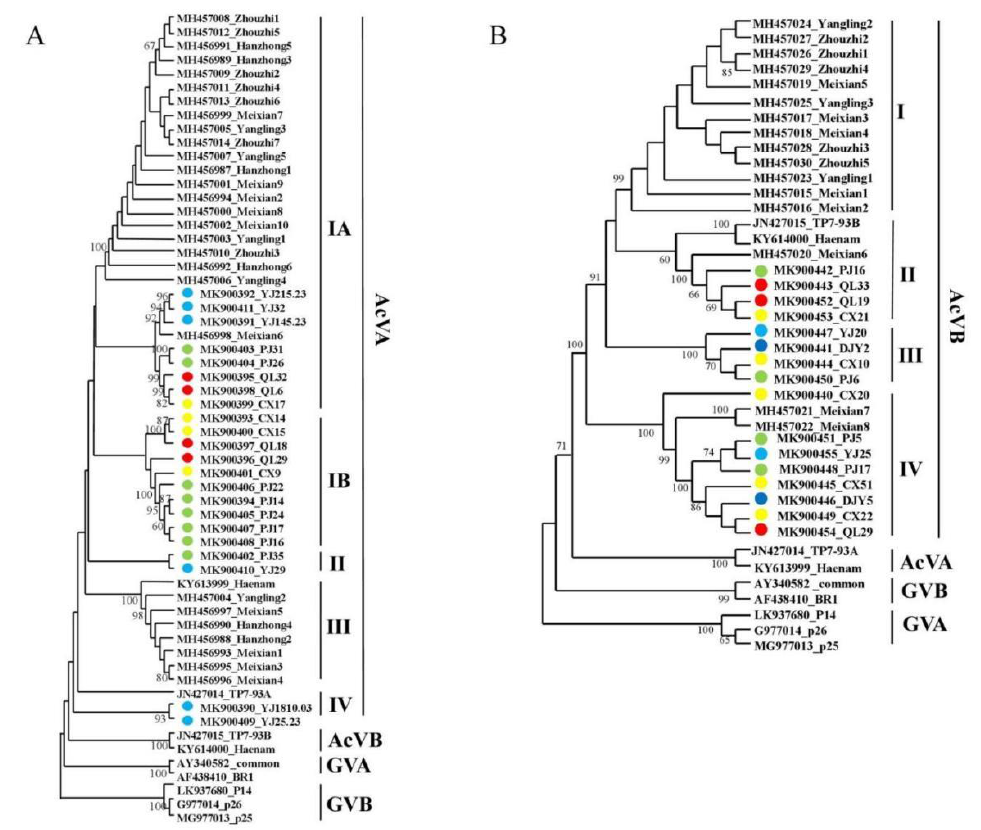
Figure 3. Phylogenetic analysis of AcVA ( A ) and AcVB ( B ), based on the CP genes. Note: Branches with a bootstrap value of > 60% are shown. Light blue represents the Ya’an isolate, green represents the Pujiang isolate, red represents the Qionglai isolate, yellow represents the Cangxi isolate, and dark blue represents the Dujiangyan isolate.